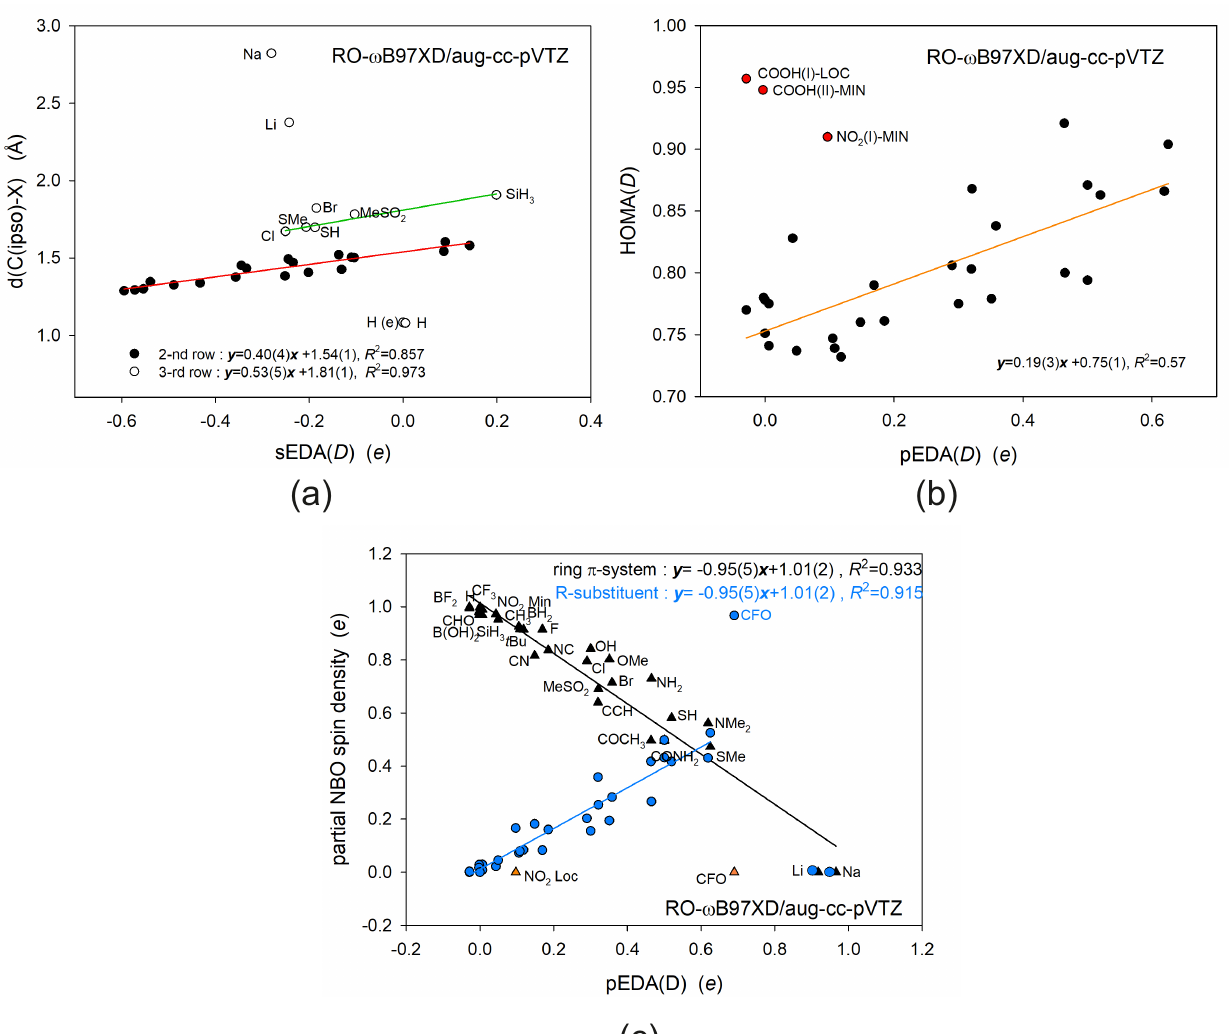
Figure 7. ( a ) Linear regression between the d(C(ipso)-X) in the cation radicals of the monosubstituted benzenes split into two straight lines: one for substituents in which the linking X atom belongs to the 2-nd row of the periodic table (red line) and the other in which it belongs to the 3-rd one (green). ( b ) Weak linear correlation between the HOMA( D ) aromaticity index of the studied cation radicals and the pEDA( D ) descriptor. ( c ) Linear correlations between the spin localized at the ring π -electron system (black) and at the substituent R (blue) and the pEDA( D ) descriptor. Points in orange and for CFO substituent (blue) were omitted in